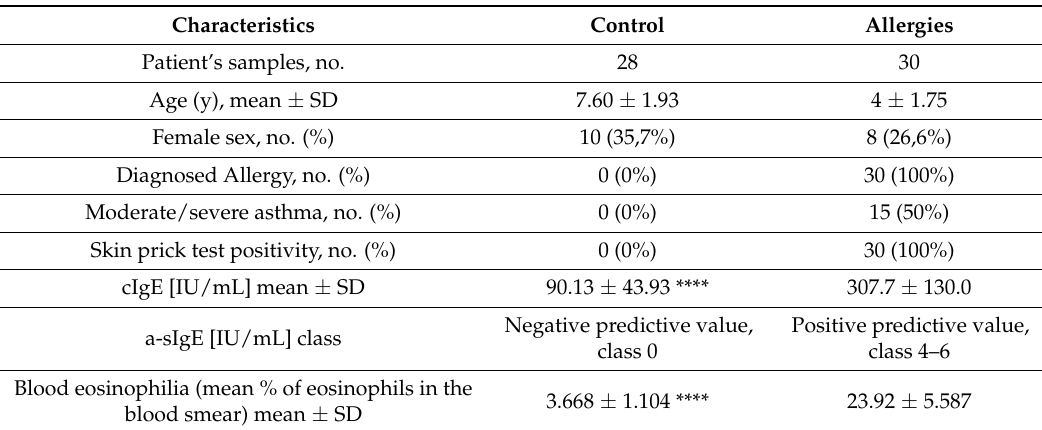
Table 1. Demographic data and clinical characteristics of the study population. Data are presented as the mean ± S.E.M. **** p < 0.0001 control group vs. children with diagnosed